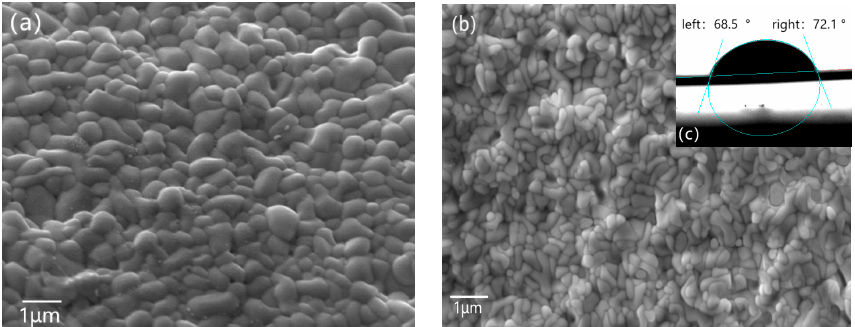
Figure 5. The SEM images of PANI with a magnification of 8000 ( a ) and bromine ion doped PANI ( b ); The water contact angle of the Br-doped PANI film ( c ).